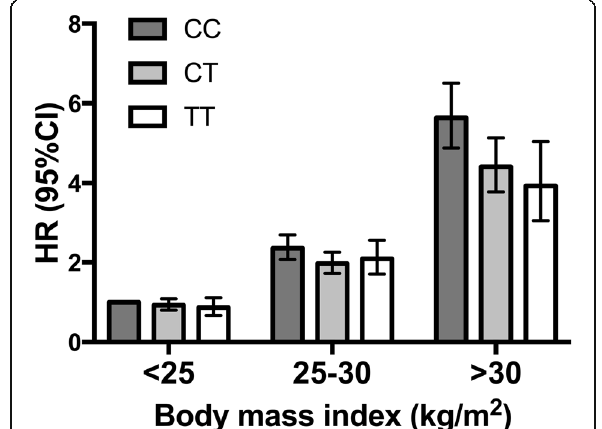
Fig. 2 Zinc supplement use and risk of T2D across SLC30A8 rs13266634 genotype in the MDCS ( n = 20,929). Hazard ratios (HR) from a Cox proportional hazards model adjusting for dietary and non-dietary confounders. P interaction (genotype × zinc supplement use) = 0.32